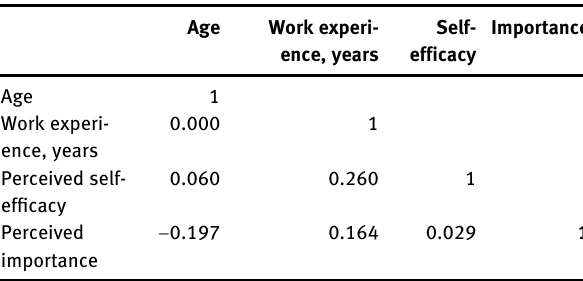
Table  : Correlationbetweenthe self-ef fi cacyfor clinicalevaluation scale and other